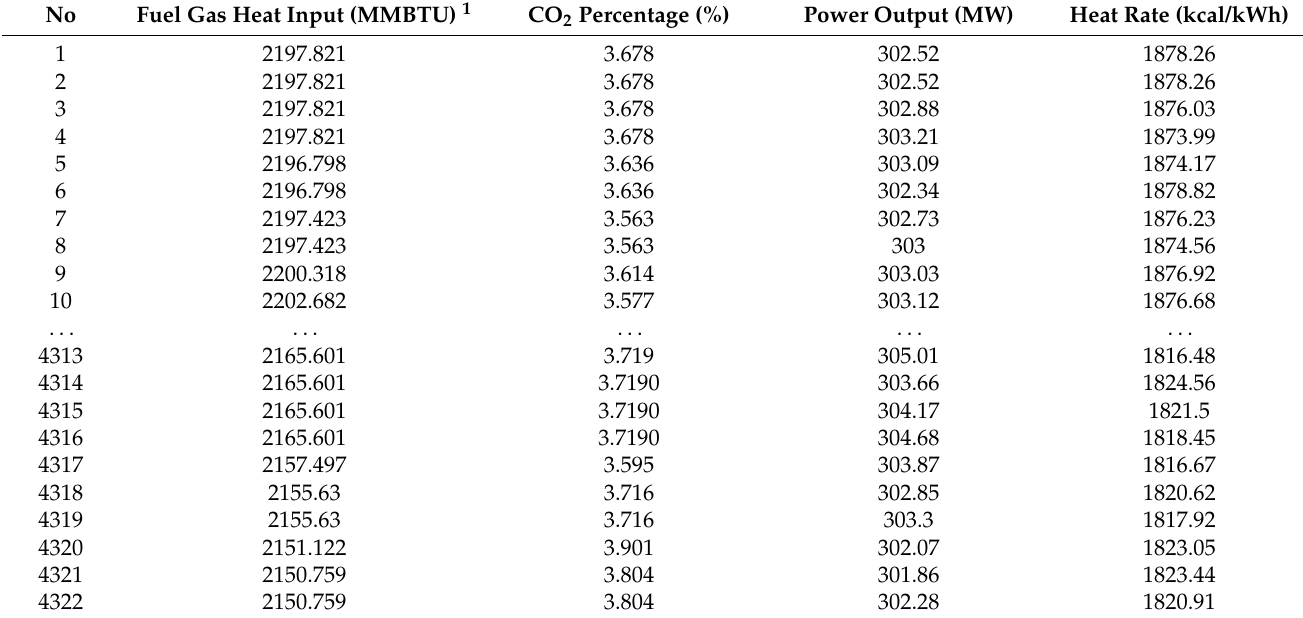
Table 1. Actual operation data used.